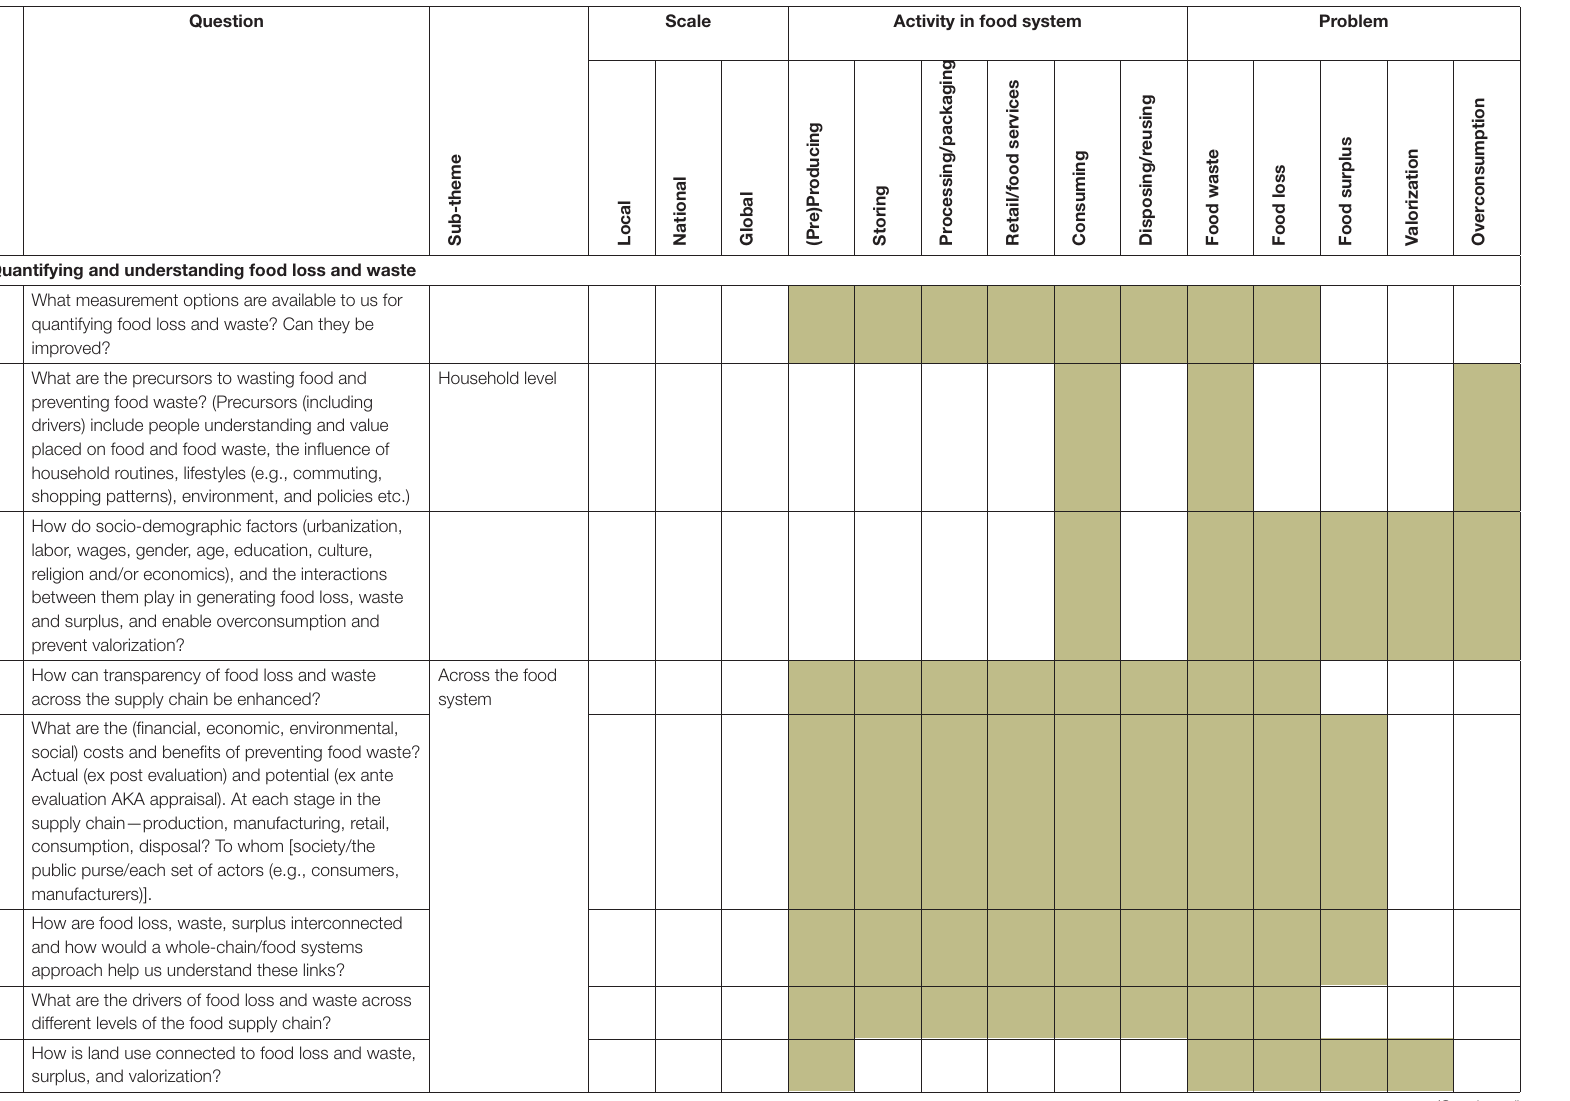
TABLE 1 | Categorization of priority research questions. Question